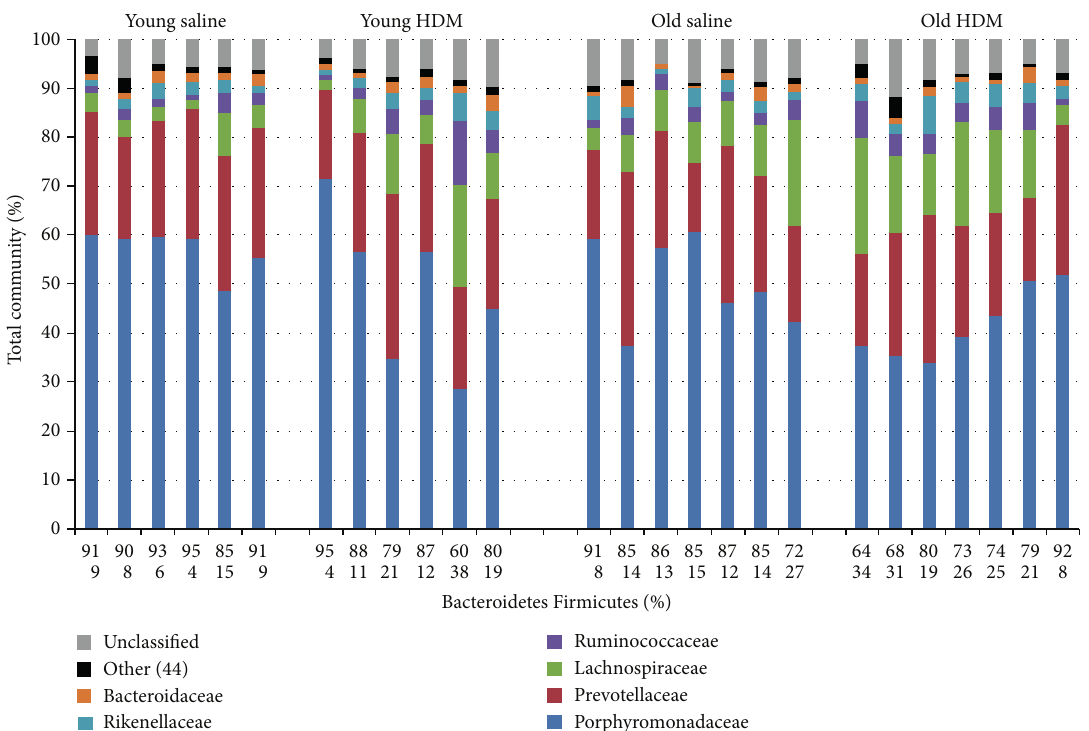
Figure 3: Fecal bacterial community structure at family level. Relative abundances of individual families as well as overall percentage of Bacteroidetes and Firmicutes are shown.